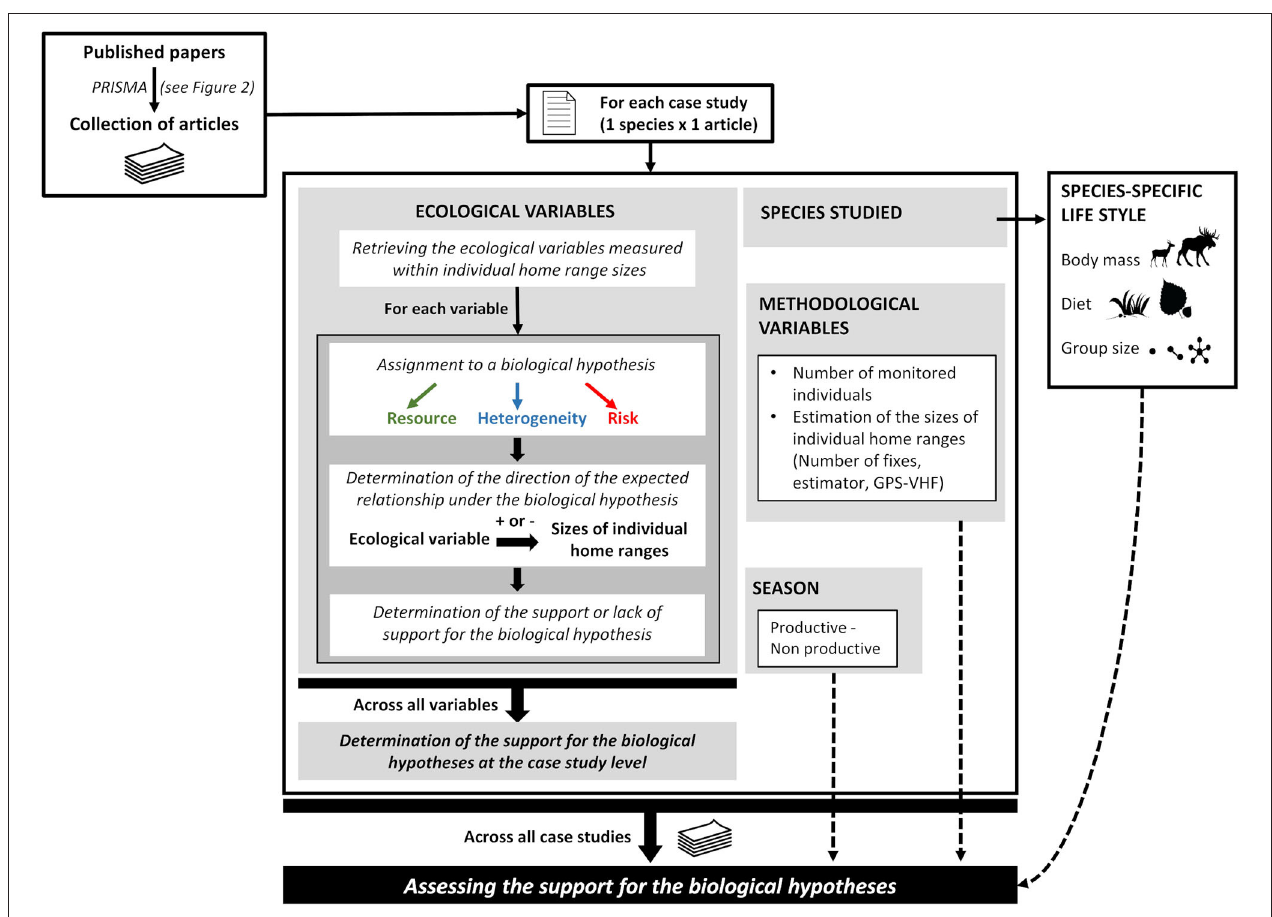
FIGURE 1 | Schematic summary of the methodological framework. We tested biological hypotheses derived from a review of the empirical literature regarding (1) the ecological drivers of the sizes of individual home ranges (resource, landscape heterogeneity, and risk) and how (2) species-specific lifestyle traits (body mass, group size, and diet) and (3) seasonal resource variation (productive vs. non-productive season) impact the level of support to each hypothesis, while taking into account methodological variables. Each article was assessed to determine whether the relationship between the sizes of individuals’ home ranges and the ecological metrics were consistent with hypotheses about the ecological drivers. The results in the article were considered supporting the hypothesis concerning ecological drivers if at least one metric was retained. The probability to support a hypothesis was evaluated using the data collected across all case studies from the review. Pictograms downloaded from http://www.phylopic.org or from the personal collection of